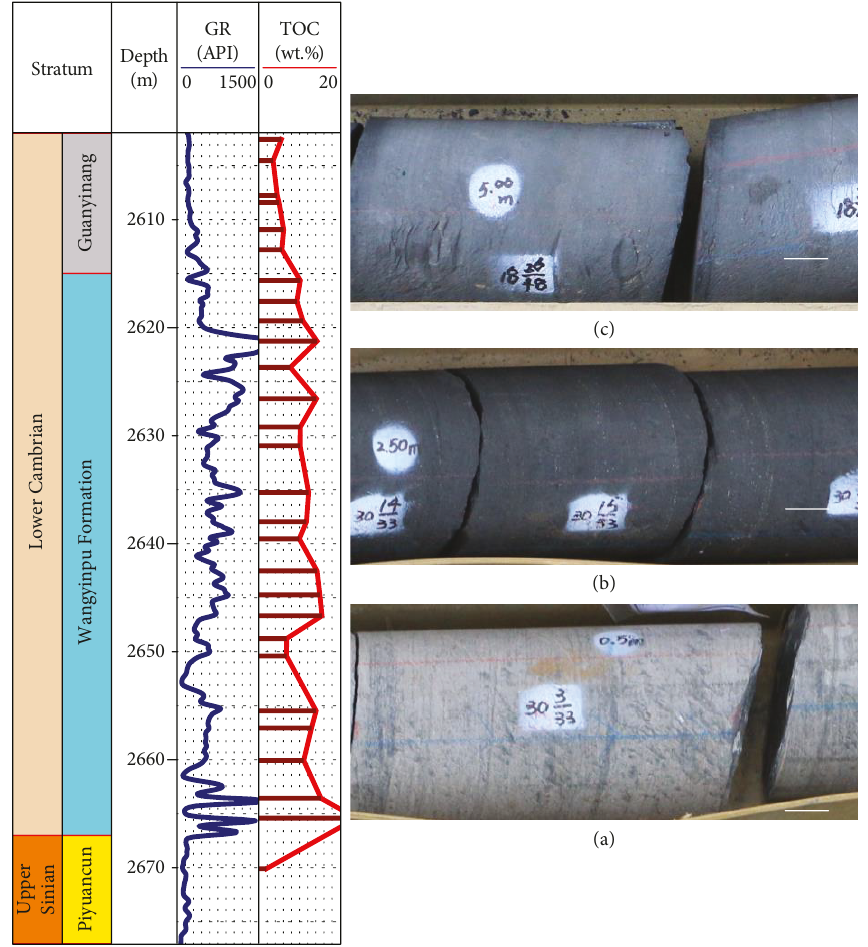
Figure 2: Stratigraphic column and core photos of the Upper Sinian Piyuancun Formation, the Lower Cambrian Wangyinpu Formation, and Guanyintang Formation in Jiangye-1 Well. (a) The Upper Sinian Piyuancun grey siliceous dolomite, 2673 m; (b) the Lower Cambrian Wangyinpu black siliceous shale, 2628m; (c) the Lower Cambrian Guanyintang dark-gray siliceous shale, 2607m. See Figure 1 for the well